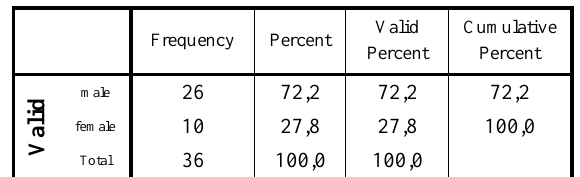
Table 2: Gender Table 4: Experience of Accounting Professionals